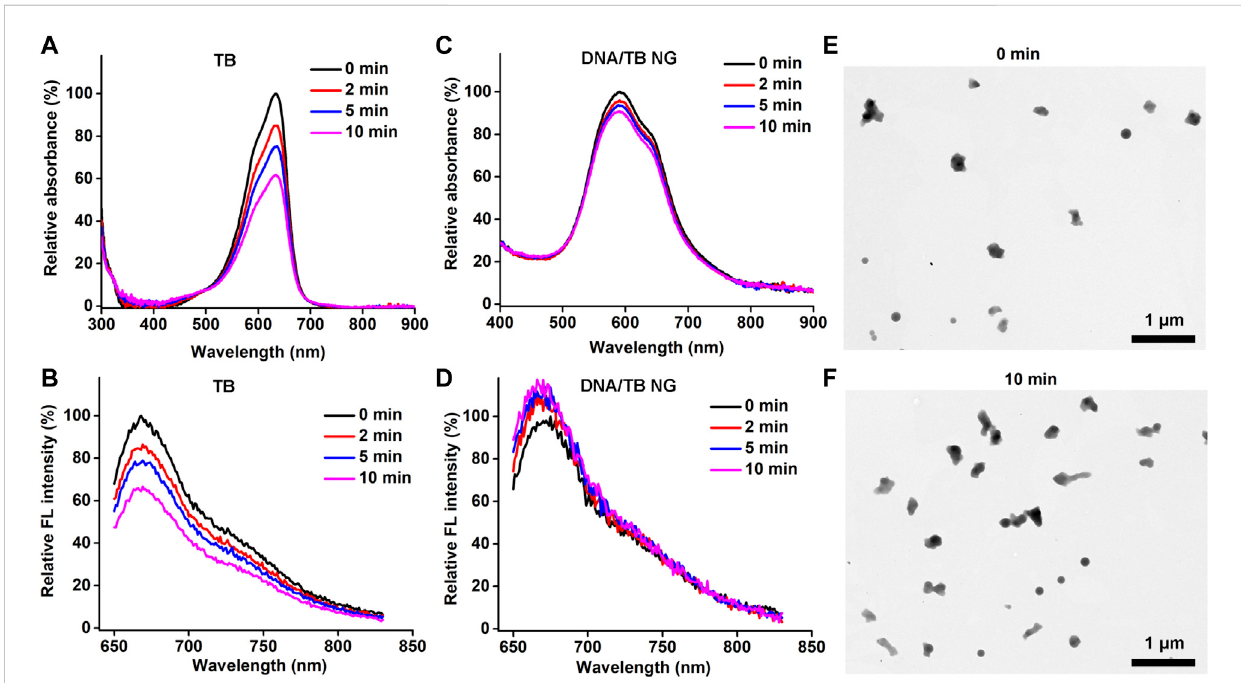
FIGURE 4 Fluorescent microscopy of MCF-7 cells treated with free TB and DNA/TB NG (8 µM of TB) for 20 h. (A) Representative fl uorescence images. (B) Intracellular TB fl uorescence intensity quanti fi ed from the fl uorescence images.